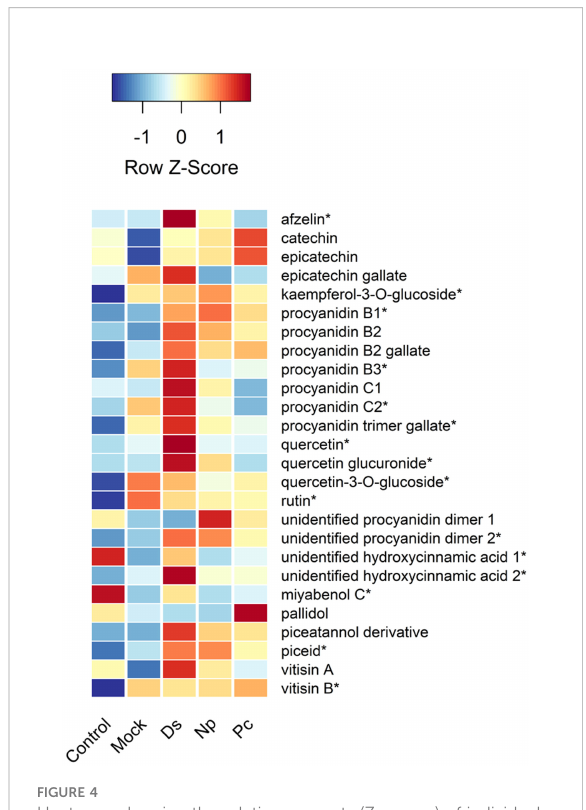
FIGURE 4 Heat map showing the relative amounts (Z-scores) of individual phenolic compounds quanti fi ed in this study and taken just prior to second inoculations. Control, NINW; Mock, NIW; Ds, Diplodia seriata ; Np, Neofusicoccum parvum ; Pc, Phaeomoniella chlamydospora . *Indicates signi fi cance at P < 0.05, with statistics provided in Table